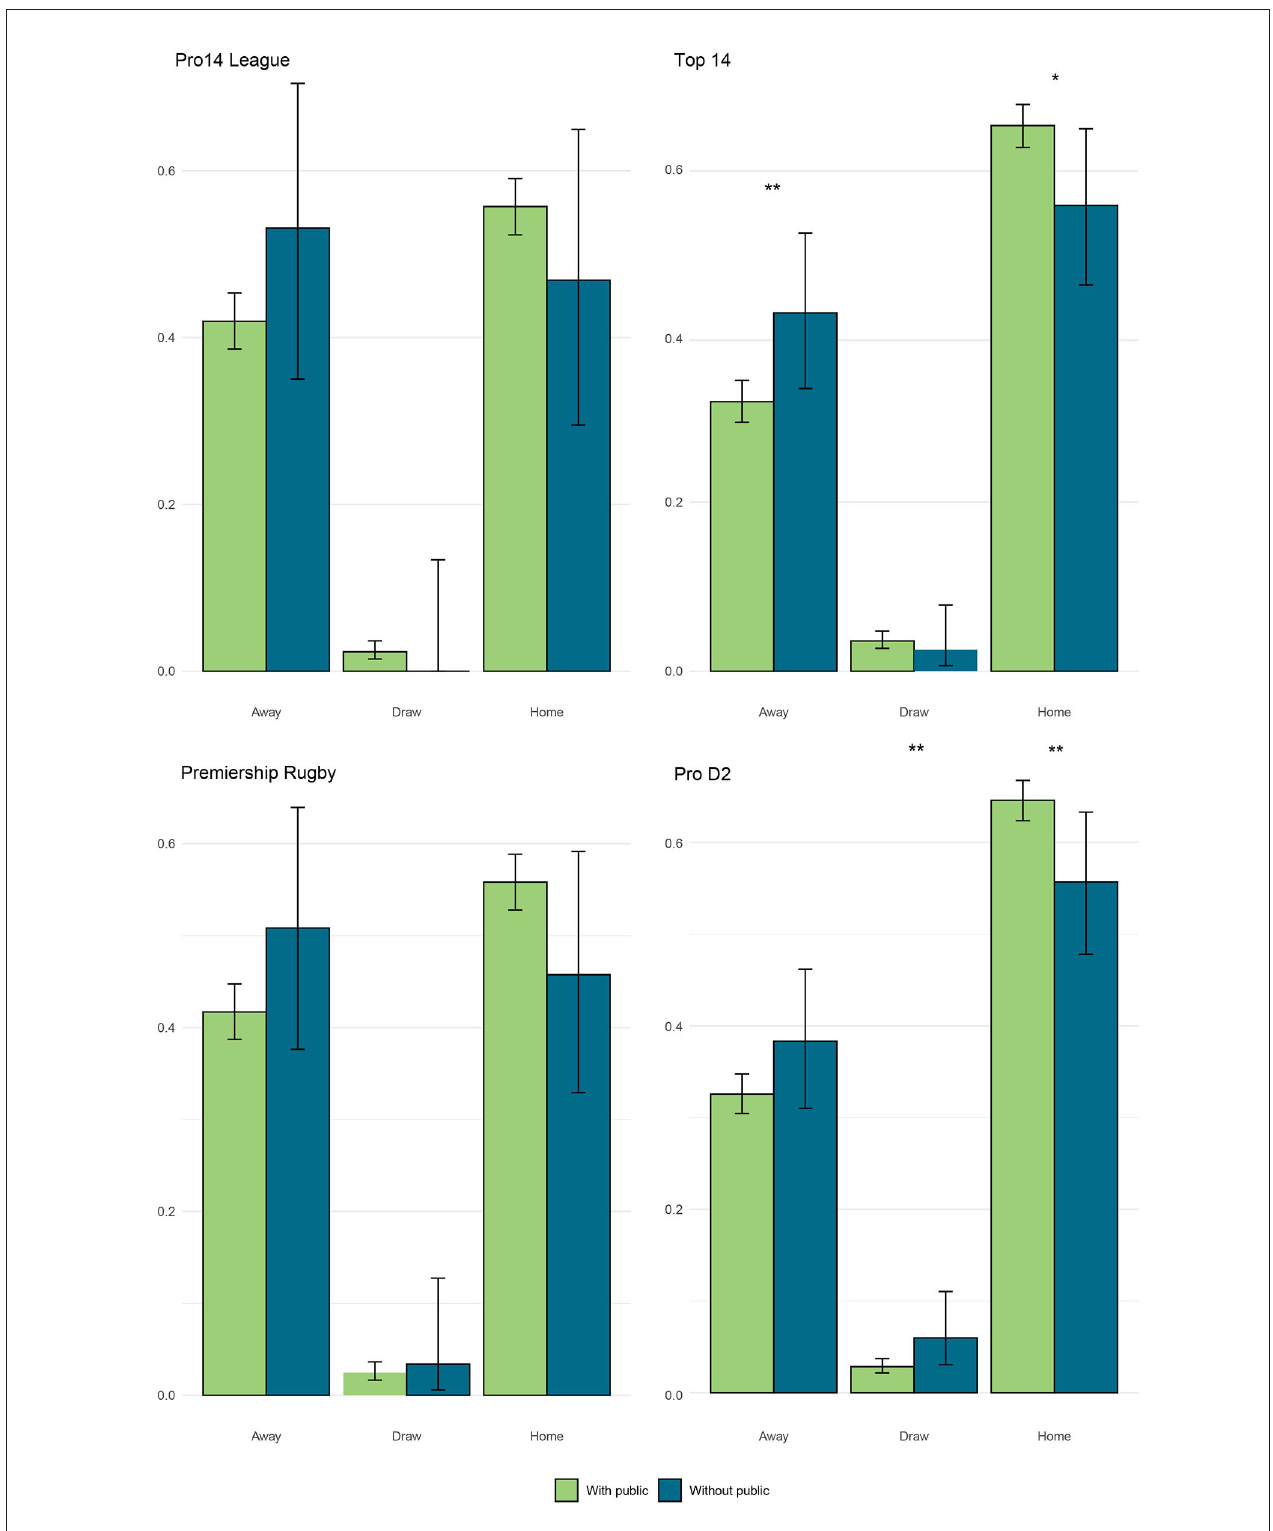
FIGURE 3 | Proportion of matches won at home, away, and drawn in the European rugby union first division championship with and without supporters. Significance thresholds were set at α = {0.1, 0.05, 0.01} (respectively *, **, ***).